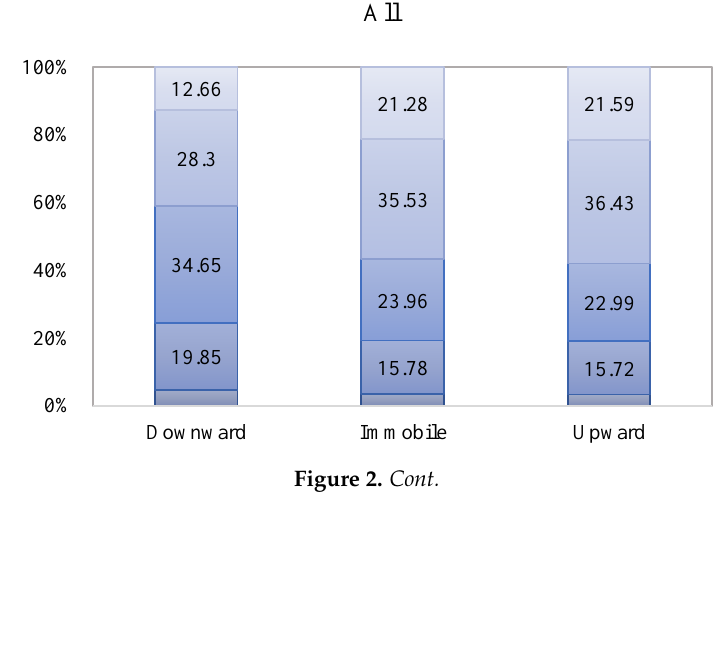
Figure 1. Geographic Distribution of Health in 2005 and 2015.